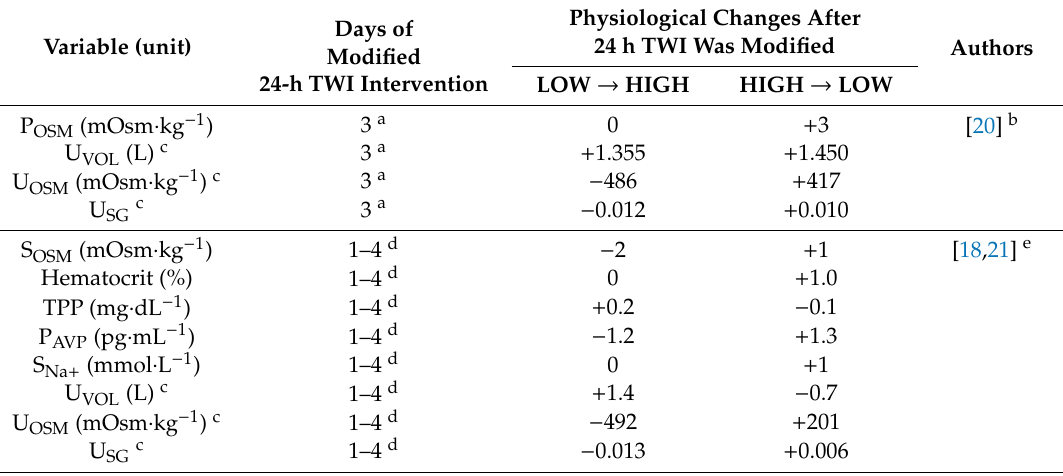
Table 2. Physiological changes that occurred when low volume (LOW) and high volume (HIGH) drinkers reversed their habitual 24-h total water intake (TWI) for 3–4 days. Baseline (pre-intervention) values appear in Table 1.